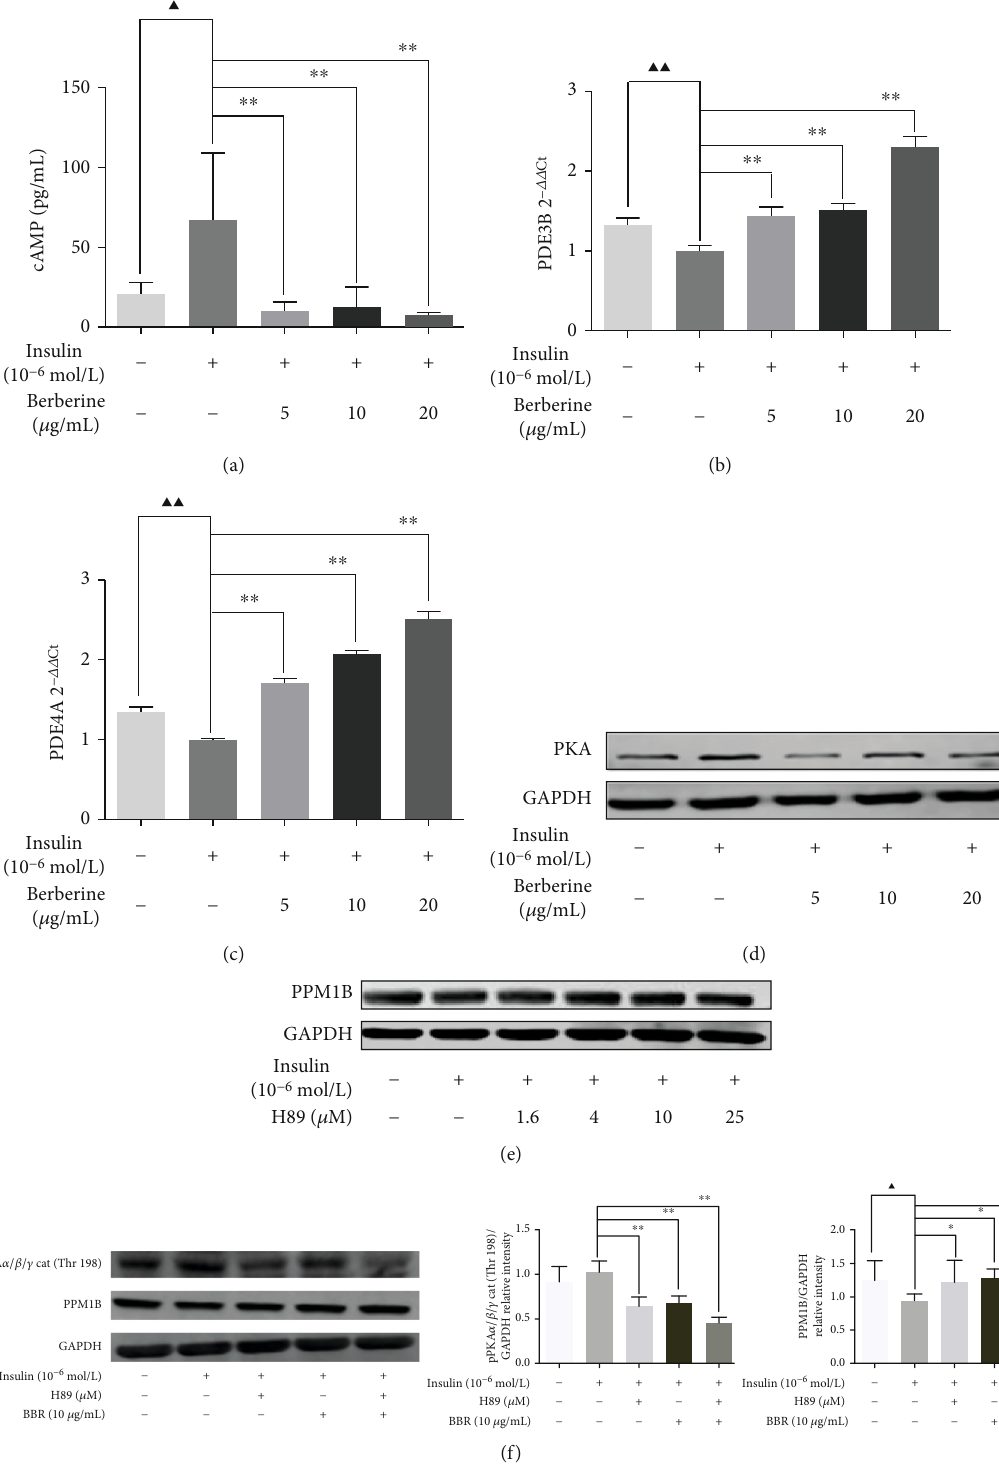
Figure 6: E ff ect of BBR on the PPM1B/cAMP/PKA pathway in HepG2-IR cells. (a) The content of cAMP measured by the ELISA kit. (b) PDE3B and (c) PDE4A mRNA expression evaluated with qPCR. (d) PKA, (e) PPM1B, and (f) phosphorylated PKA protein levels in total HepG2-IR cell extracts. ▲ P < 0 : 05 and ▲▲ P < 0 : 01 , Con vs. model; ∗ P < 0 : 05 and ∗∗ P < 0 : 01 , model vs. H89/BBR-treated